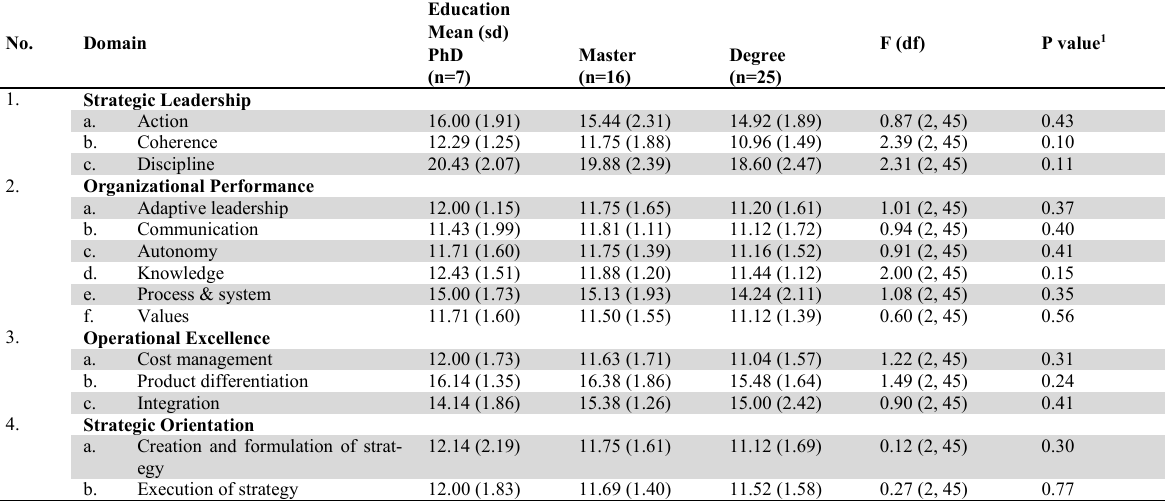
The mean score different of education level in Proton n=48 No.